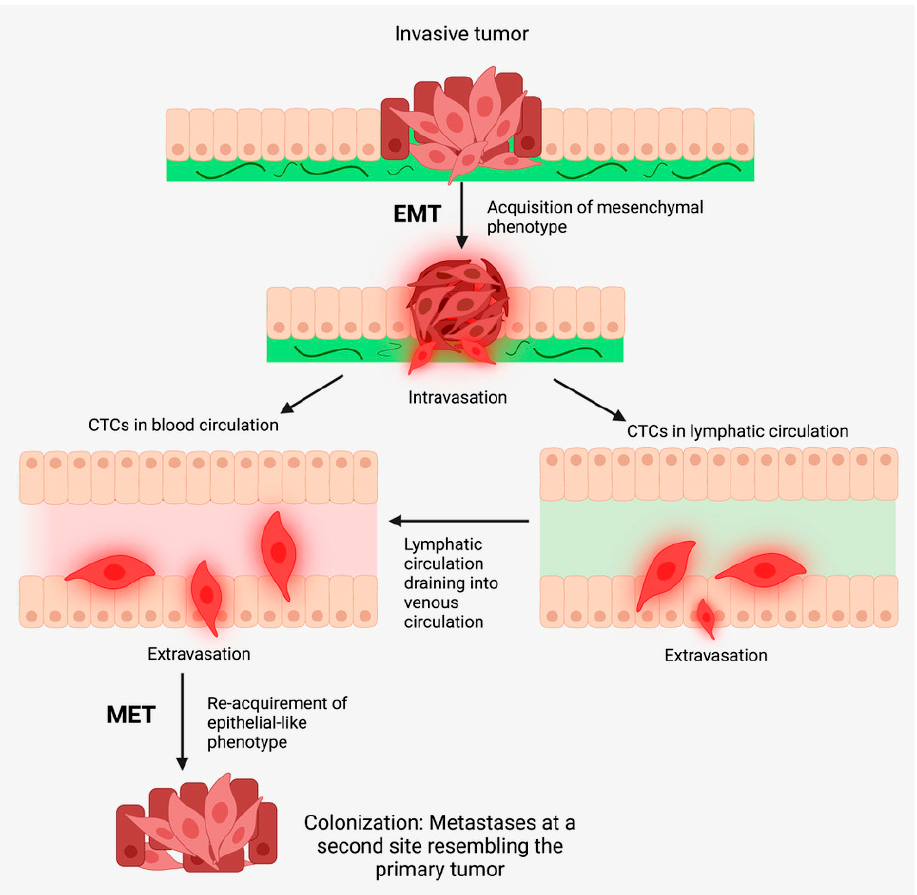
Figure 2. In cancer metastasis, tumor cells undergo epithelial-mesenchymal transition (EMT) to form mesenchymal-like cells, which undergo intravasation to enter the blood and/or lymphatic circulations as circulating tumor cells (CTCs). CTCs then undergo mesenchymal-epithelial transition (MET) and extravasate into distant tissue sites, where metastases may form. Adapted from the Atlas of Extreme Facial Cancer, Springer Nature, 2022 [9]. Diagram recreated with BioRender.com, accessed on 1 November 2022.